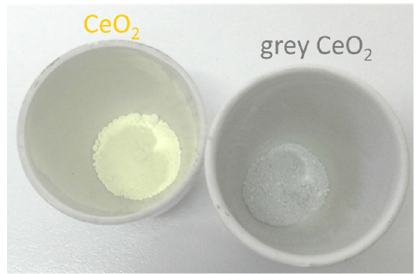
Figure 1. Photo of the as-synthetized powders.